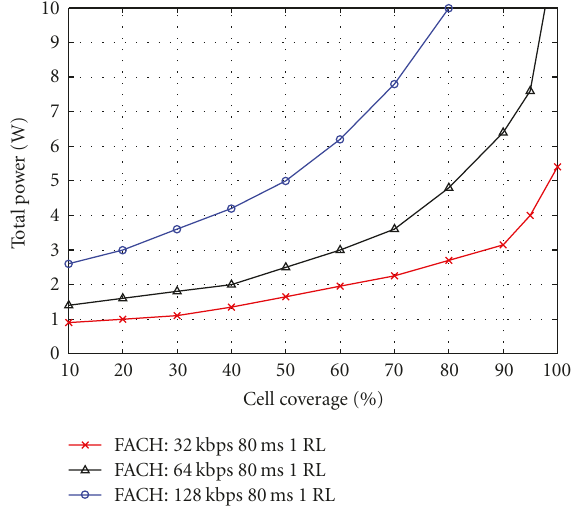
Figure 3: FACH Tx power with Dynamic Power Setting (RL: Radio Link).